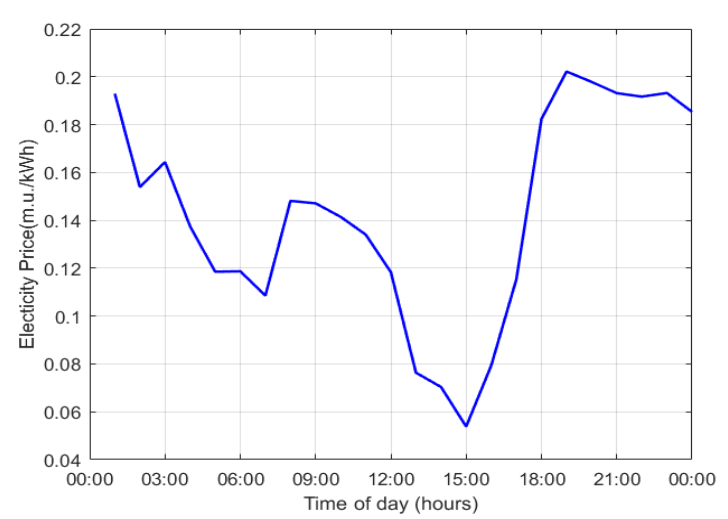
Figure 5. Electricity price.